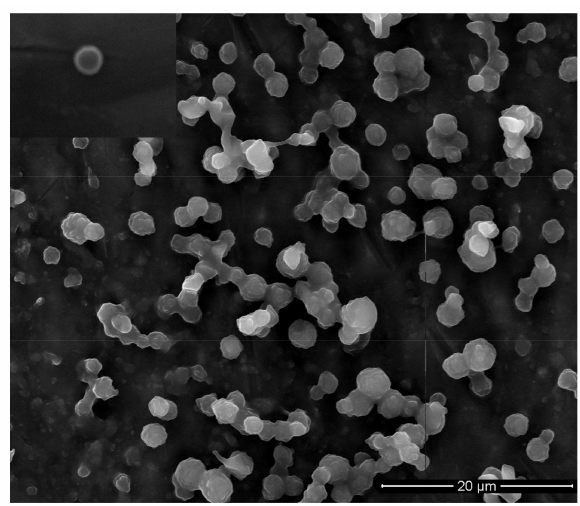
Figure 10. SEM image of DOX-loaded mPEG 43 - b -P[(TMC-C) 20 -TMC 20 ] micelles.